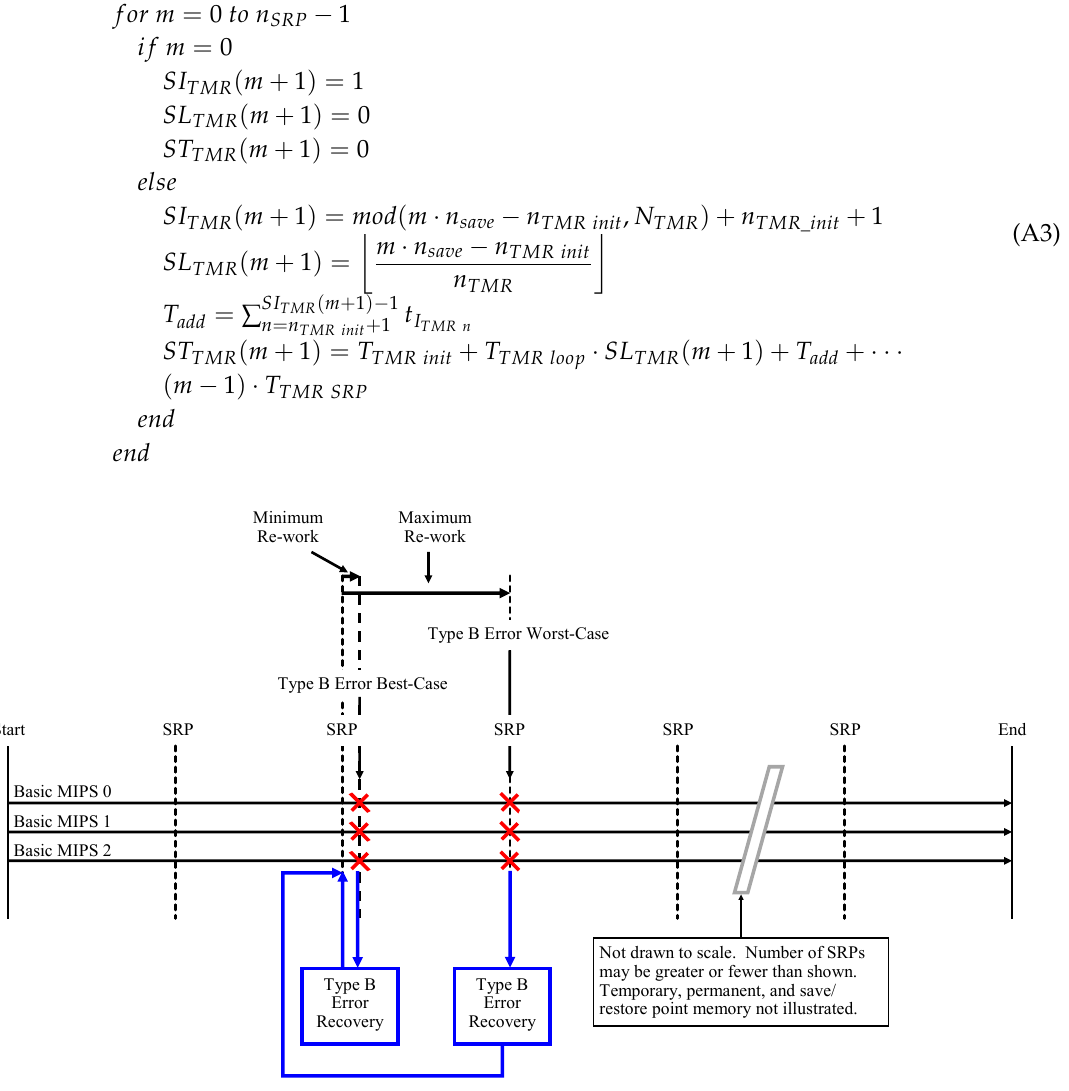
Figure A5. TMR MIPS Type B Best- and Worst-Case error timing